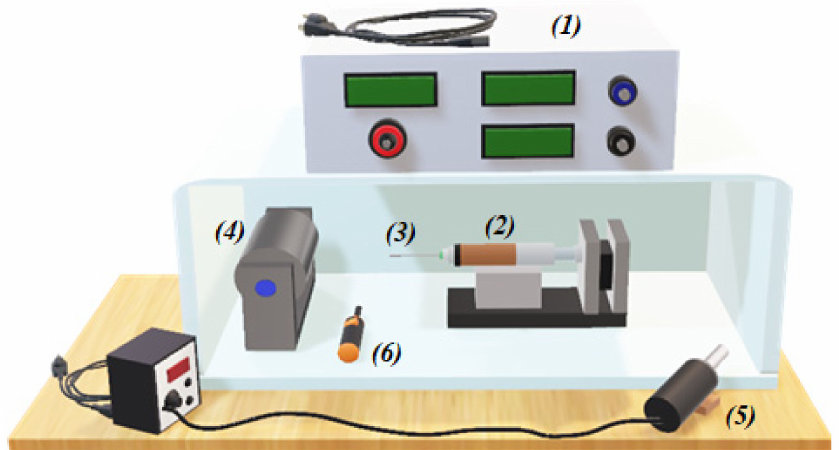
Figure 1. Configuration of the electrospinning device used for the fabrication of the PVA/HC/EEHP membranes: ( 1 ) high-voltage power supply, ( 2 ) syringe pump, ( 3 ) capillary (stainless steel needle), ( 4 ) rotating collector, ( 5 ) hot-air gun (welding station), and ( 6 )